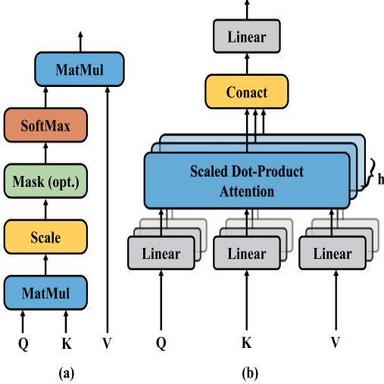
The framework of automatic delamination characterization using improved THz-TDS based on Transformer-based neural network.